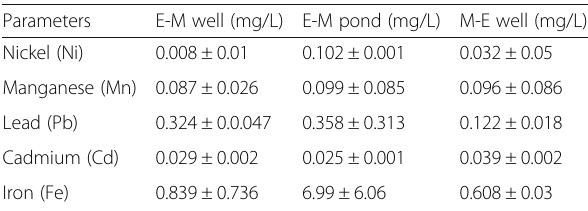
Table 4 Heavy metal content of Edege-Mbeki and Mararaban- Edege water samples Parameters